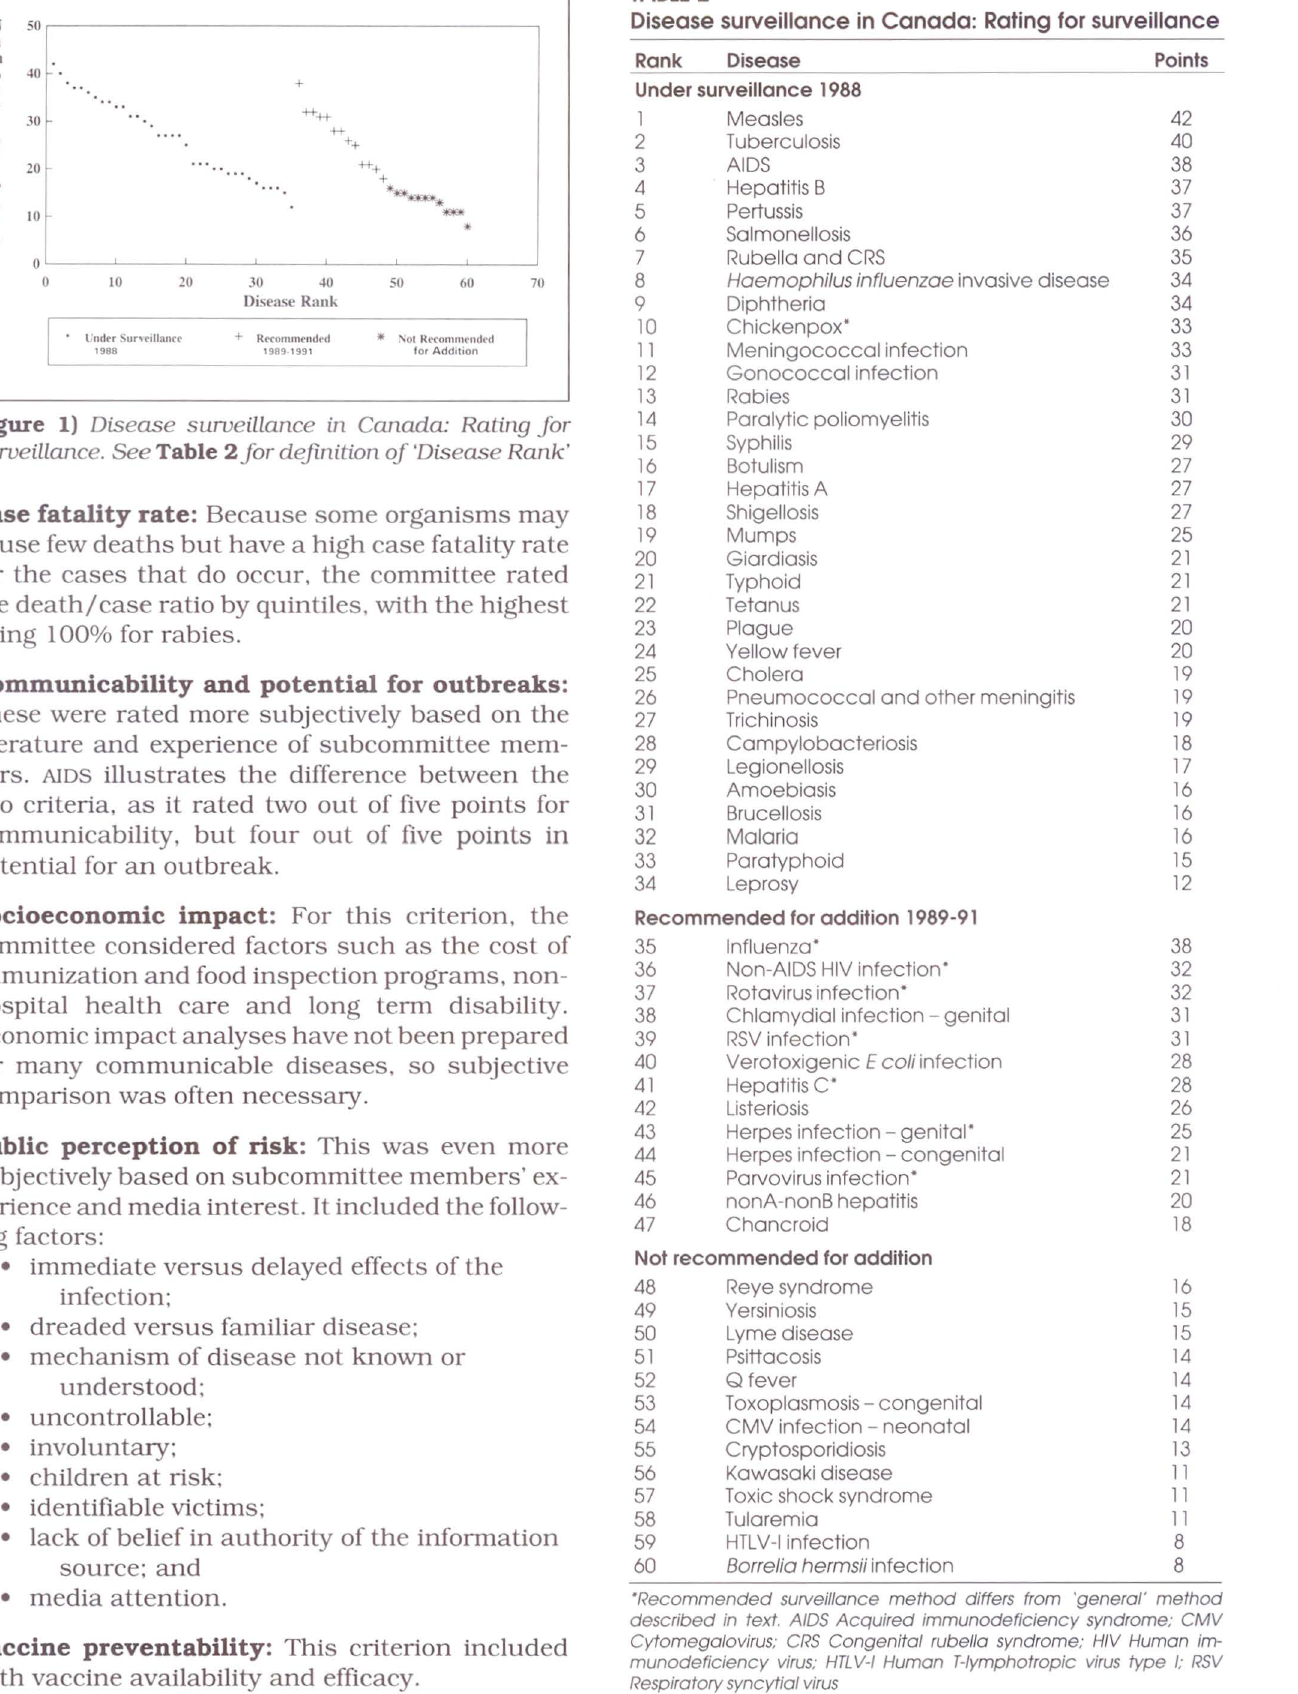
Disease surveillance in Canada: Rating for